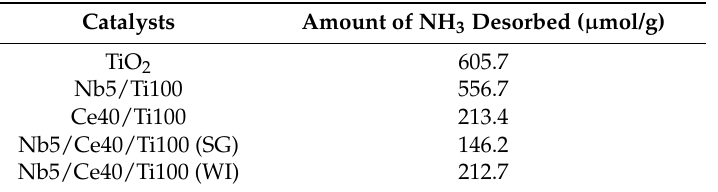
Figure 6. NH 3 -TPD plots of supported Ceria-based catalysts and reference materials. Table 3. Total amount of NH 3 desorbed in from the fresh samples.